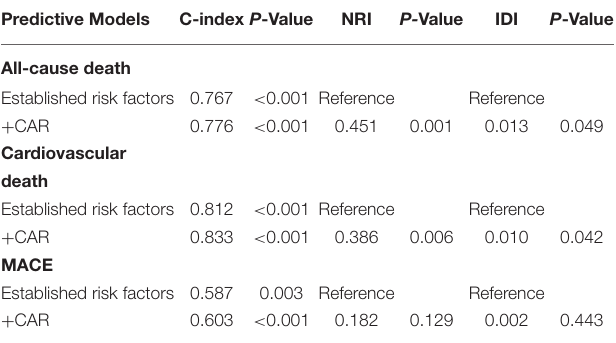
TABLE 4 | Discrimination of each predictive model for outcomes using C-index, net reclassification improvement (NRI), and integrated discrimination improvement